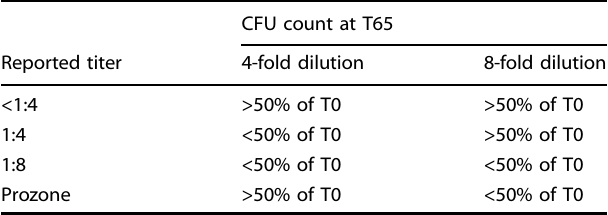
Table 1. Possible outcomes of enc-hSBA measurements in an individual test with 4-fold and 8-fold diluted samples used for titer determination.